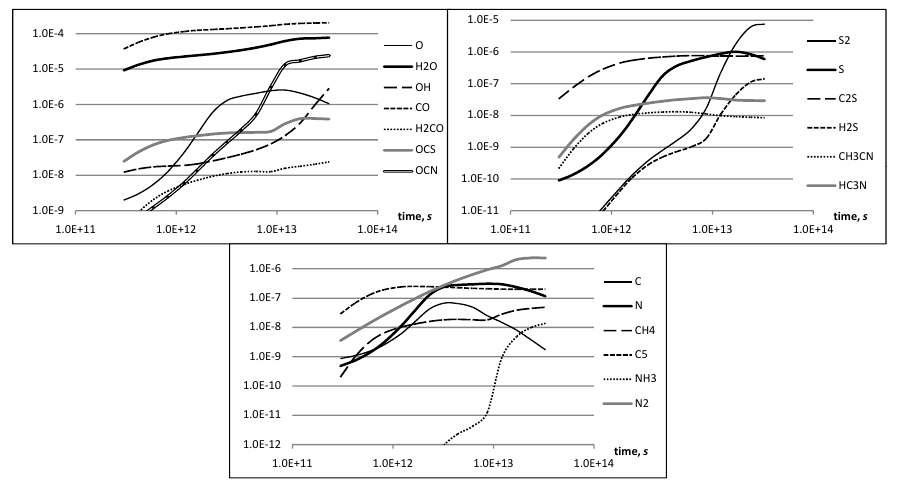
Fig. 3. Calculated solid-phase relative abundances for selected species for Model 2 (with freeze processes). Pay attention to the relative abundance (ordinate) scale for each graph.